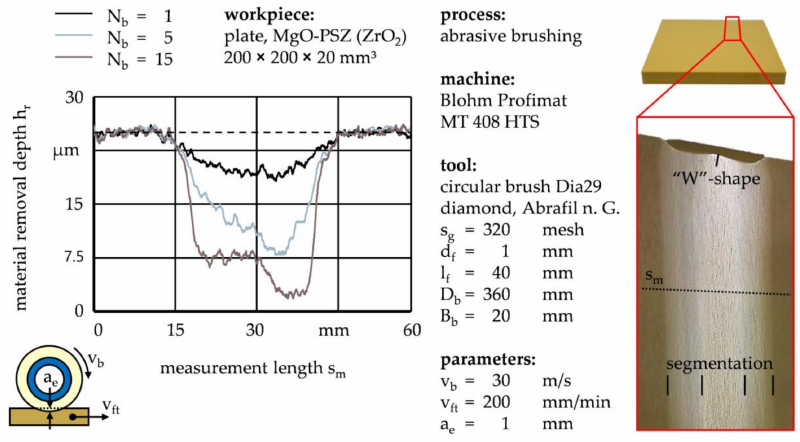
Figure 14. Material removal depth h r , measured across the width of an overbrushed profile.